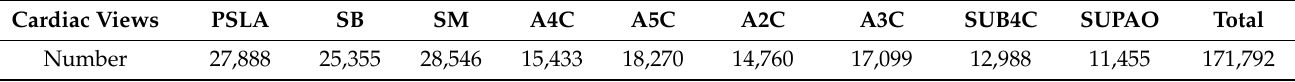
Table 1. Distribution of cardiac views from SXPPH.